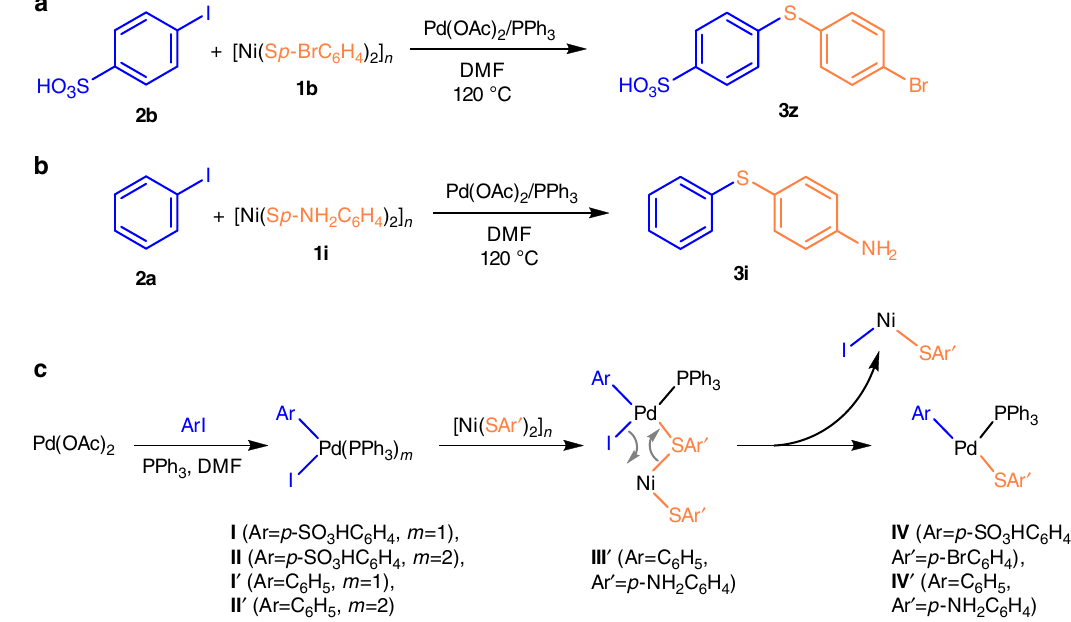
Fig. 5 ESI-MS study of the reaction mechanism in solution. Model reactions used for on-line ESI-MS monitoring in negative ( a ) and positive ( b ) ion modes, and intermediates detected in ESI-MS experiments ( c ). Gray arrows (intermediate III ’ ) show the cleavage and formation of chemical bonds